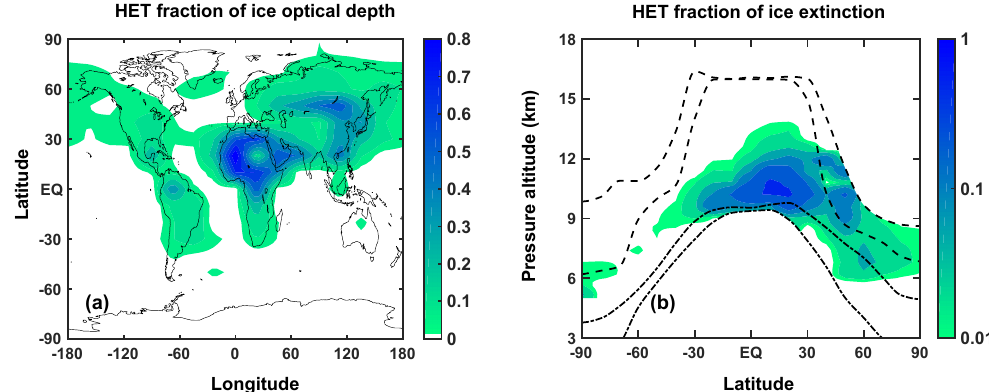
Figure 3. Fraction of total ice formed through heterogeneous freezing in ULAQ-CCM averaged over the years 2003–2012, as a function of latitude and longitude for the total optical depth (a) and as a function of altitude and latitude for the zonally averaged extinction (b) . In panel (b) , the color scale is logarithmic, ranging from 0.01 (i.e., 1% of total ice extinction) up to 1 (100%). The dashed lines show the mean tropopause height with seasonal variability (where seasonal variability is defined as ± 1 σ of the average height). The dash-dotted lines show the mean height (with seasonal variability) at which T = 238K (freezing is allowed for colder temperatures).